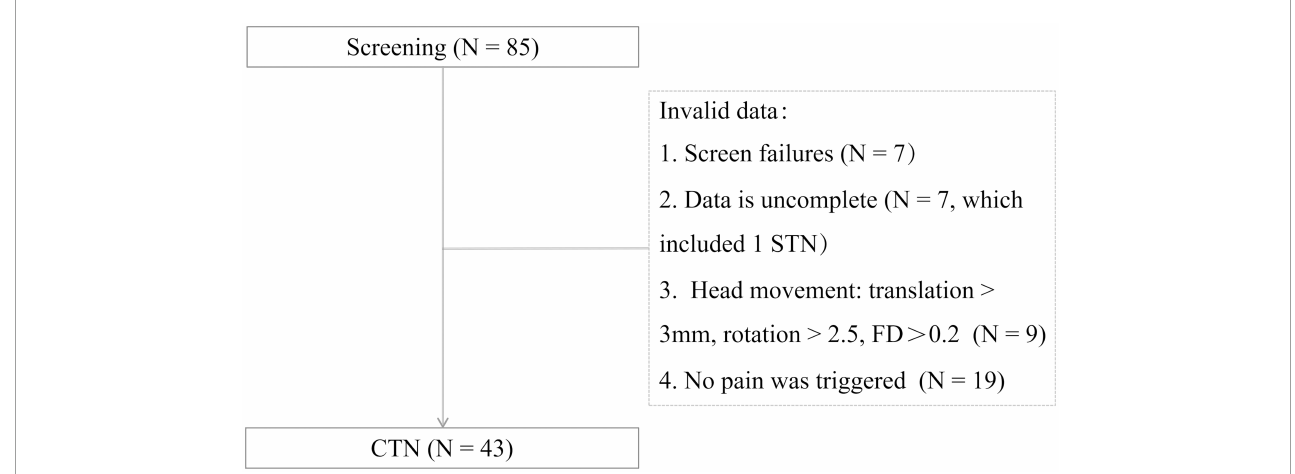
FIGURE1 Participant selection. FD, framewise displacement; STN, secondary trigeminal neuralgia; CTN, classical trigeminal neuralgia.